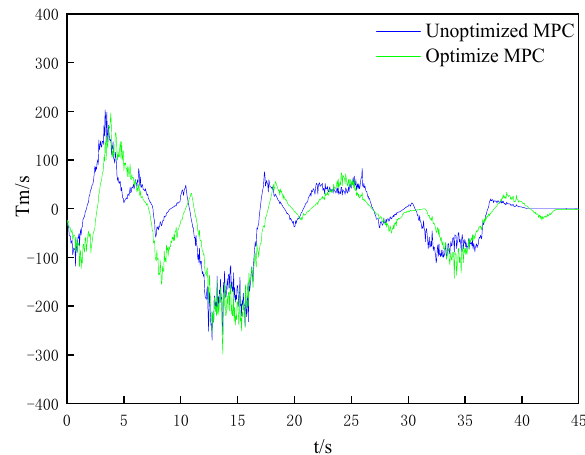
Figure 11. Test results of motor torque.